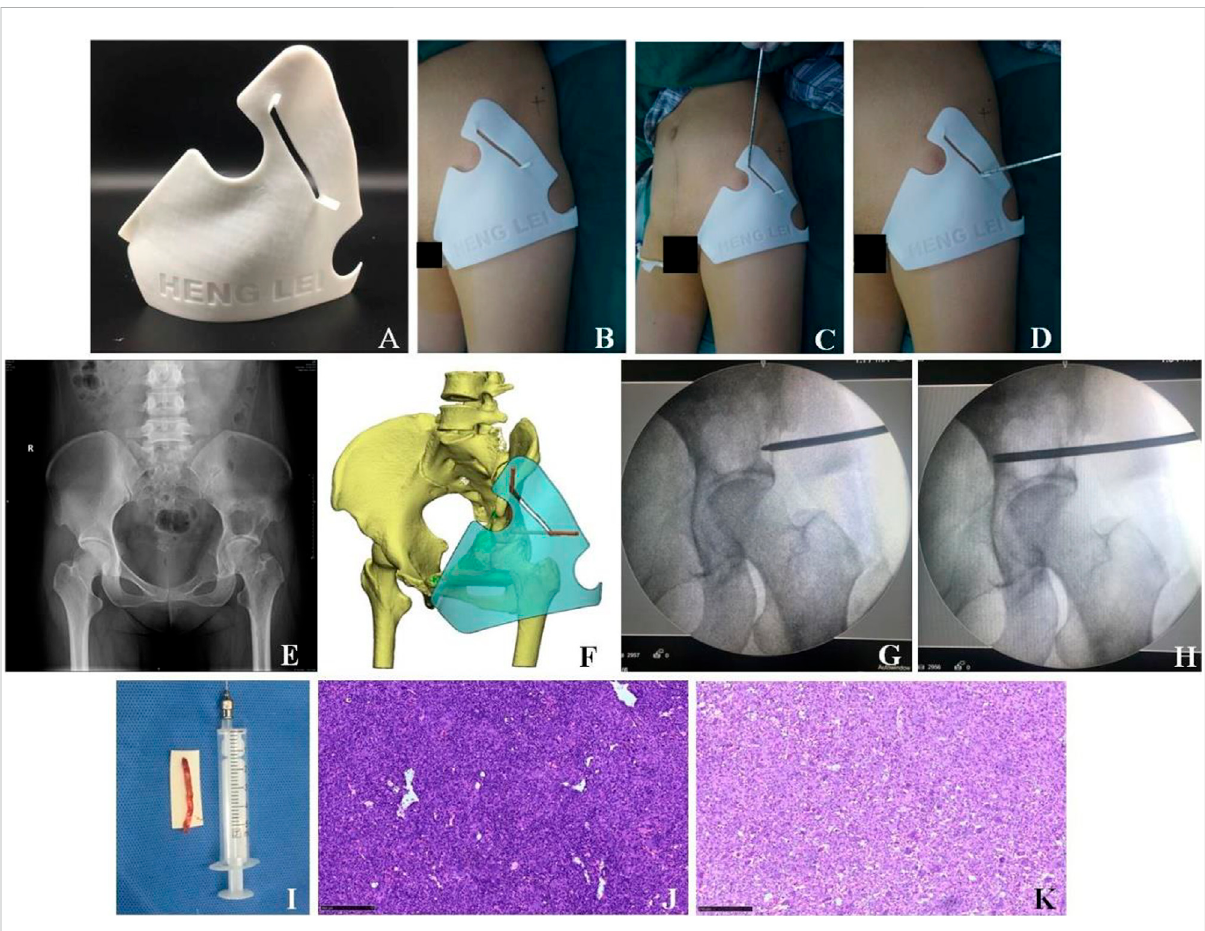
FIGURE 3 Clinical treatment of the 3D printing individualized guide plate. (A) Appearance of the 3D printing individualized guide plate. (B – D) Surgical procedures. (E) X-ray showed the bone tumor in the left acetabulum. (F) 3D model of the individualized guide plate. (G – H) Puncture location was con fi rmed by intraoperative X-ray fl uoroscopy. (I) Tissue sample was obtained by needle biopsy. (J) Pathological section was obtained by needle biopsy(×100, HE staining). (K) Pathologicalsection(×100, HEstaining)after thetumorresectionsuggested giantcell tumorofbone, which was consistent with that of (J)